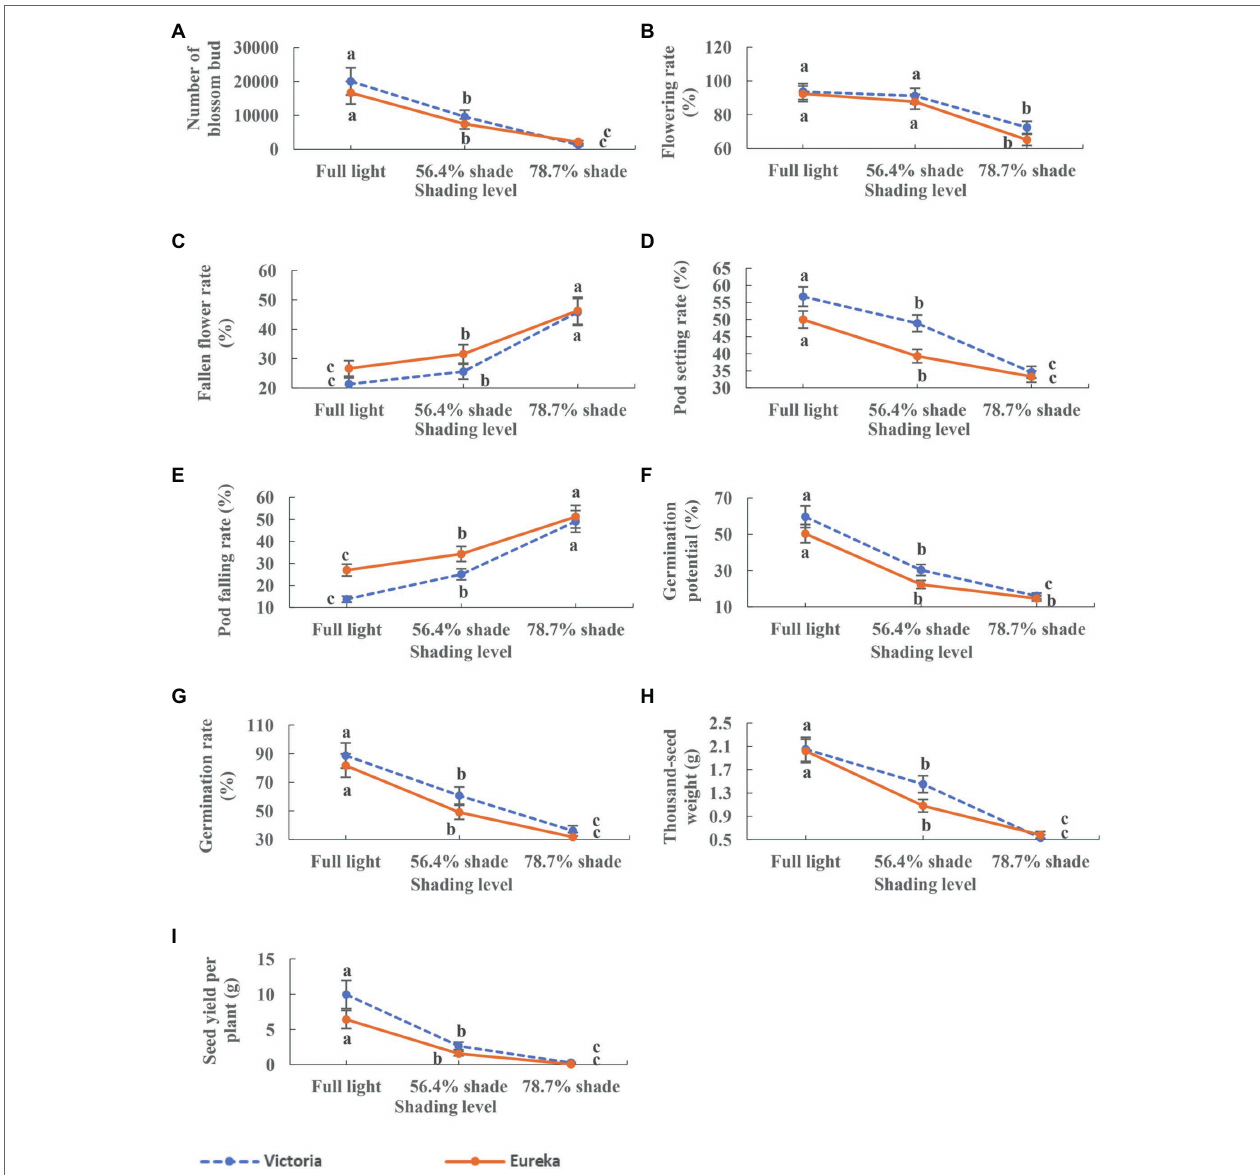
FIGURE 4 | Dynamics of flowering, fruiting, and seed traits of two alfalfa cultivars under different shading levels. (A) Number of flower bud, (B) flowering rate, (C) fallen flower rate, (D) pod setting rate, (E) pod falling rate, (F) germination potential, (G) germination rate, (H) 1,000-seed weight, and (I) seed yield per plant. Different low case letters indicate significant differences under different shading levels at 0.05 level ( p < 0.05),